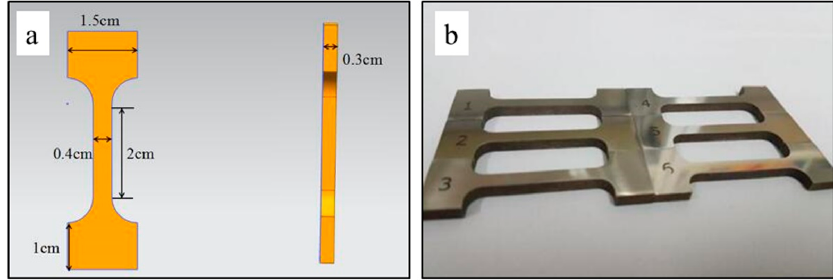
Figure 2. ( a ) Dimensional drawing and ( b ) optical image of tensile samples.